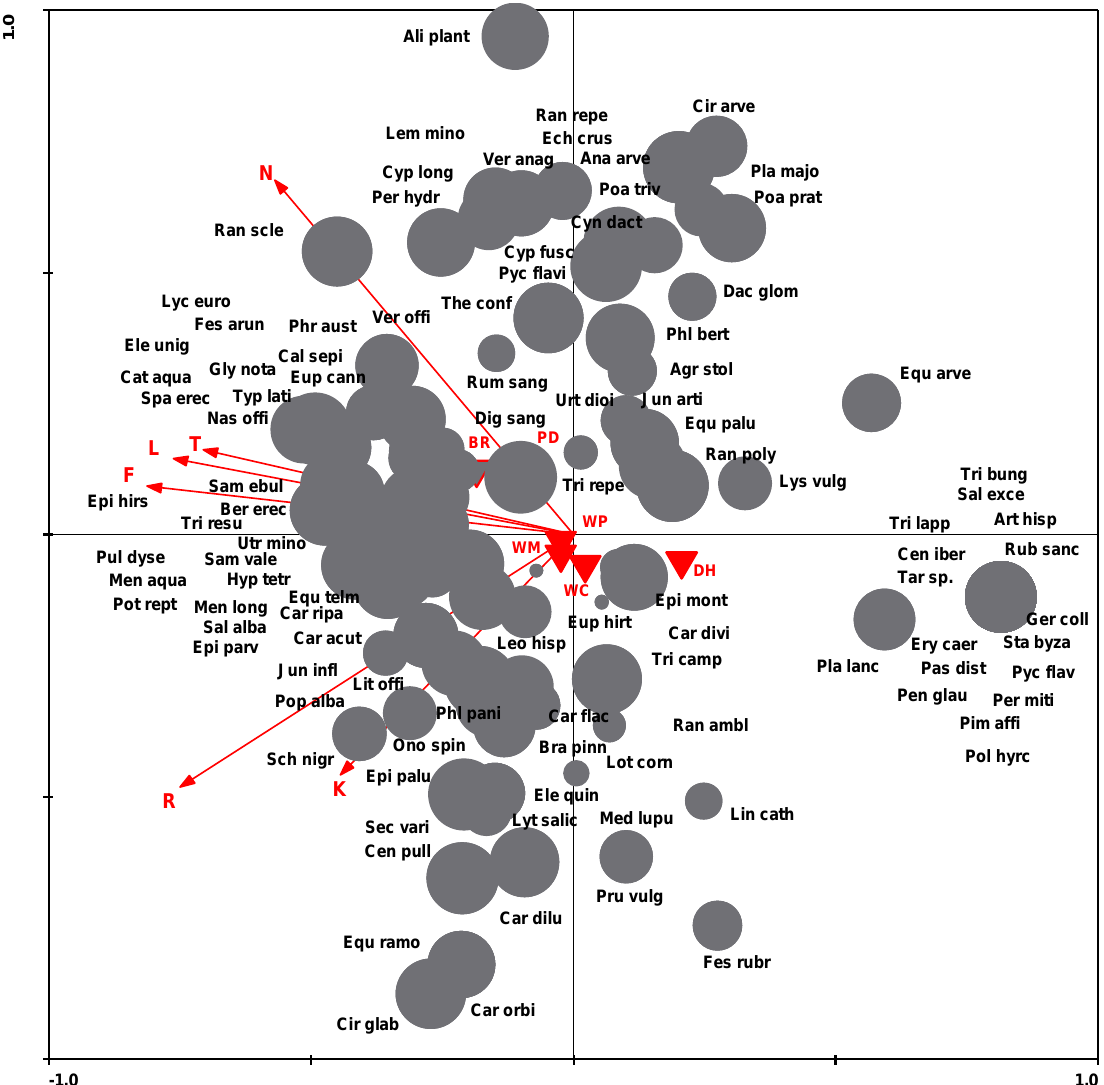
Figure 4. PCA of Ellenberg indicator values for species occurring in Chaman-e Kelar Mire. The fit of species into the ordination spaces is expressed by different dot sizes. Habitat types: WC = patches of Carex orbicularis on wet peat hummocks; PD = peaty depressions with stagnant surface water; BR = brooklets; DH = dry hummocks; WM = wet meadows; WP = loose watery peat patches along the brooklets. Ellenberg indicators: L = light; T = temperature; K = continentality; F = moisture; R = reaction; N = nutrients. Species names are abbreviated to the first three letters of the genus and the first four letters of the specific